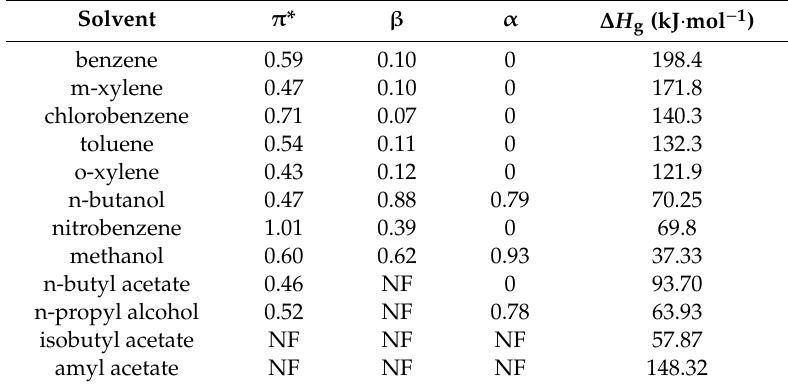
Table 2. The Kamlet–Taft parameters and enthalpy values of compound 4 in some solvents.